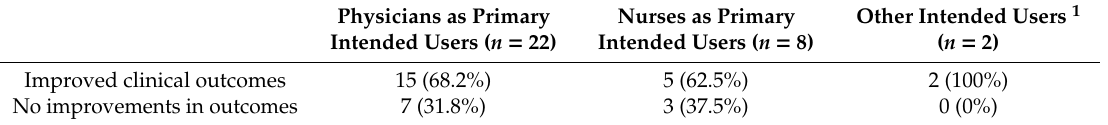
Table 4. Distribution of studies regarding intended users of EHR-based predictive models and improvement in clinical outcomes after implementation. Only studies that reported evaluations of e ff ects of model implementation on clinical outcomes are included in the